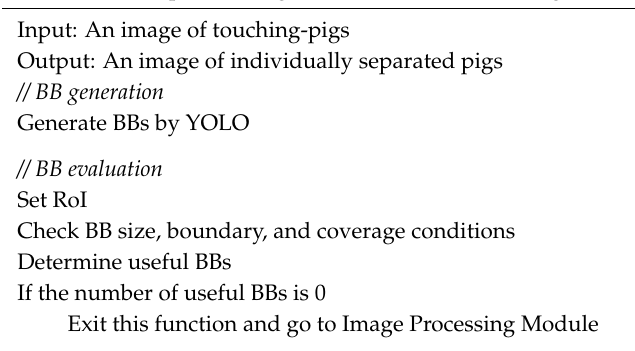
Algorithm 2 Separation algorithm of YOLO Processing